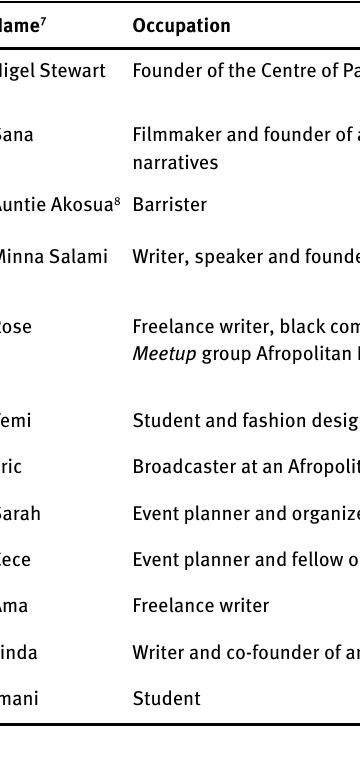
Table 1: Group of research